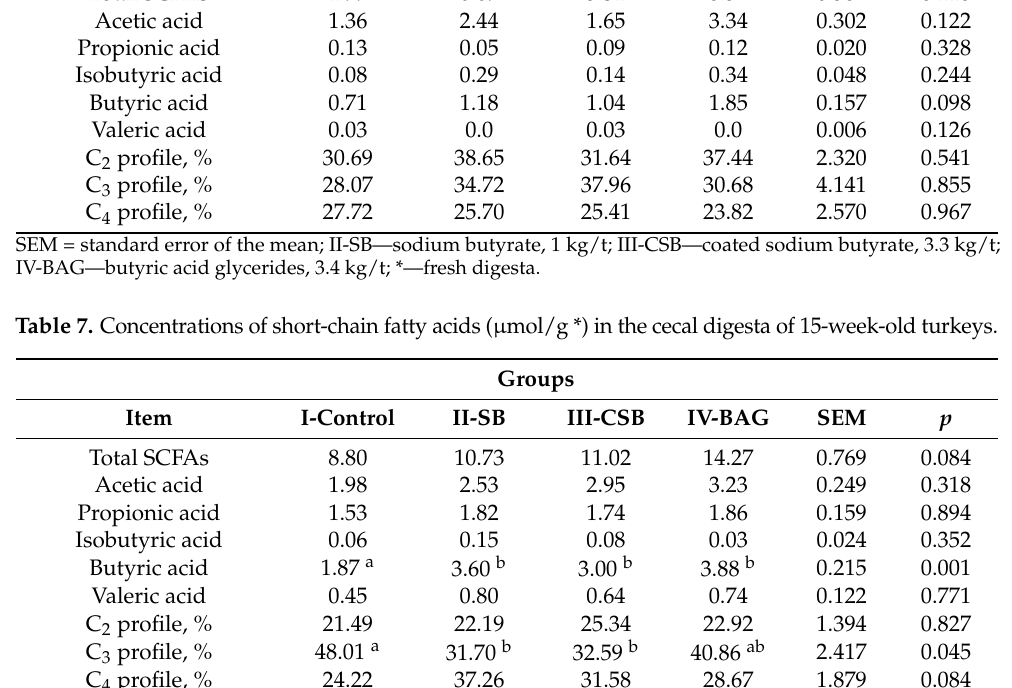
Table 6. Concentrations of short-chain fatty acids ( µ mol/g *) in the cecal digesta of 6-week-old turkeys.